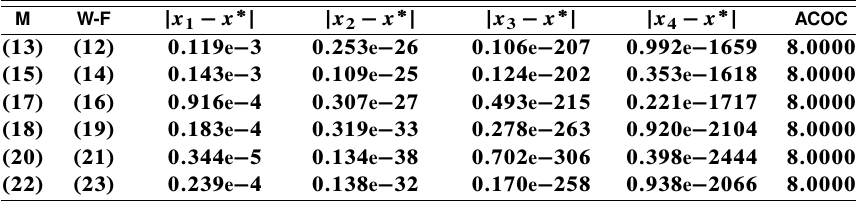
Table 4. Comparison for f.x/ D .x (cid:0) 2/.x 10 C x C 1/ e (cid:0) x (cid:0) 1 ;x (cid:3) D 2;x 0 D 2:1 , for different methods (M) and weight functions